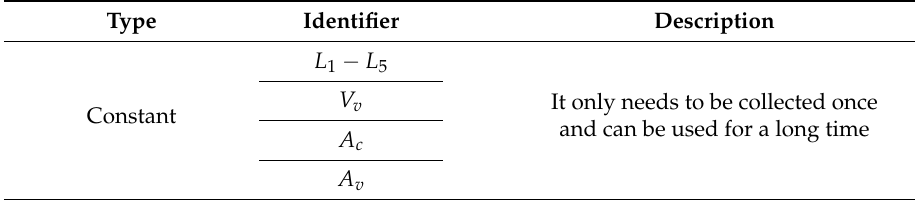
Table 7. Type of